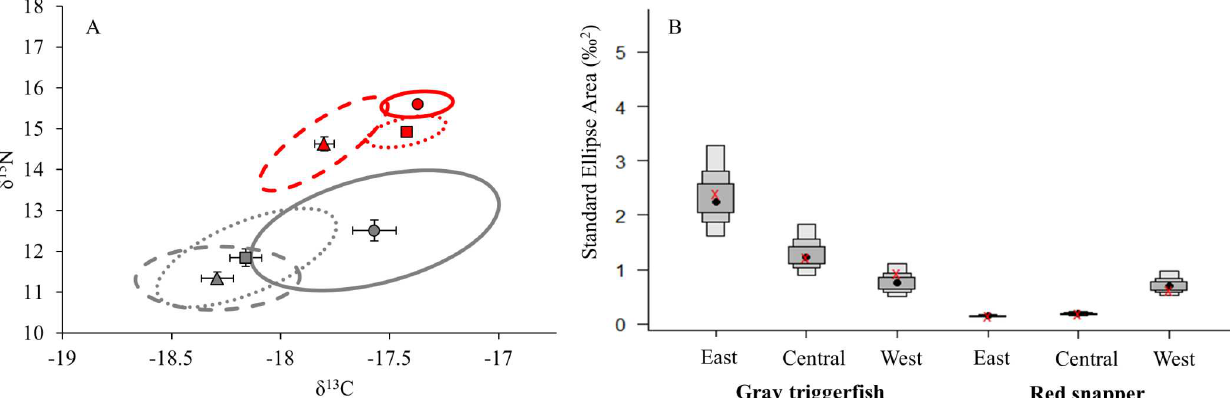
Fig 6. Species core isotopic niches and Bayesian credibles by region, based on standard ellipse areas. (A) Standard ellipse areas contain 40% of the data for gray triggerfish (gray), and red snapper (red). Stable isotope means and ellipses (SEA c ) from length adjusted stable isotope values are shown for the east (circles, solid ellipses), central (squares, dotted ellipses), and west (triangles, dashed ellipses) regions; error bars represent the standard error. (B) Bayesian credible intervals for gray triggerfish and red snapper standard ellipse areas by region. Black points represent the mean, while gray boxes represent 50, 75, and 95% credible intervals. Red x’s represent SEA corrected for sample size (SEA c